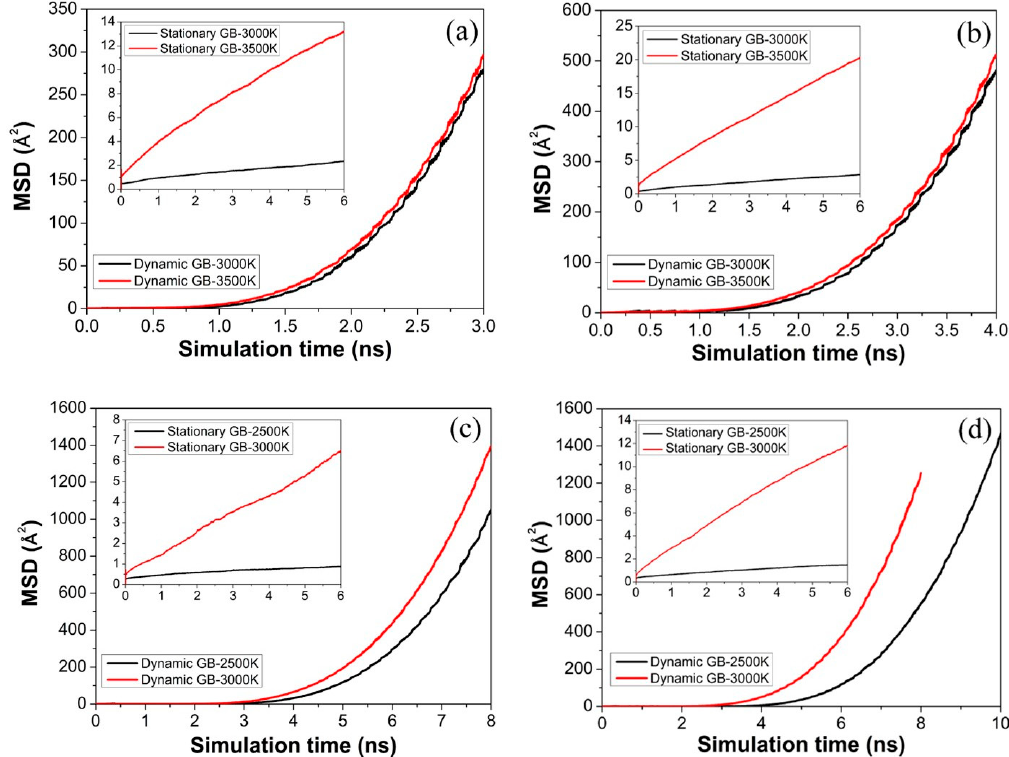
Figure 6. The mean-squared displacement (MSD) value as a function of the simulation time of different GBs during dynamic moving: ( a ) Σ 25(710) GB; ( b ) Σ 13(510) GB; ( c ) Σ 5(310) GB; and ( d ) Σ 29(520) GB. The inserted figures show the MSD value of the GBs at a stationary state.